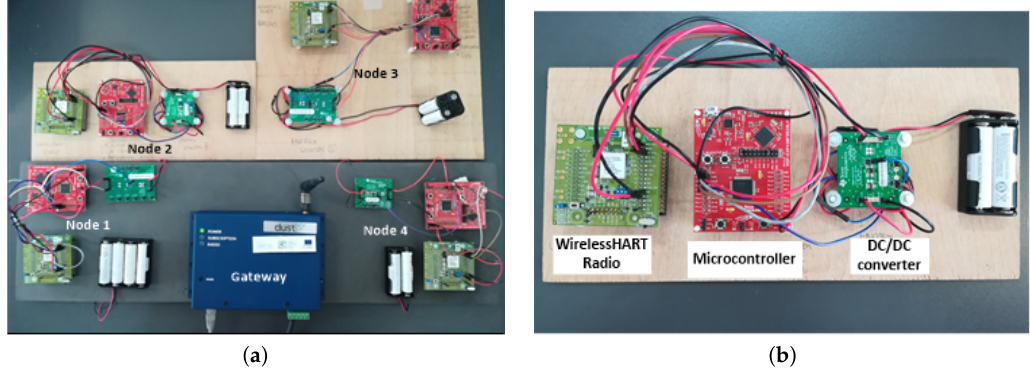
Figure 2. Validation of the monitoring architecture using a WirelessHART testbed. On the left ( a ) the Gateway and four sensor nodes, on the right ( b ) the sensor node